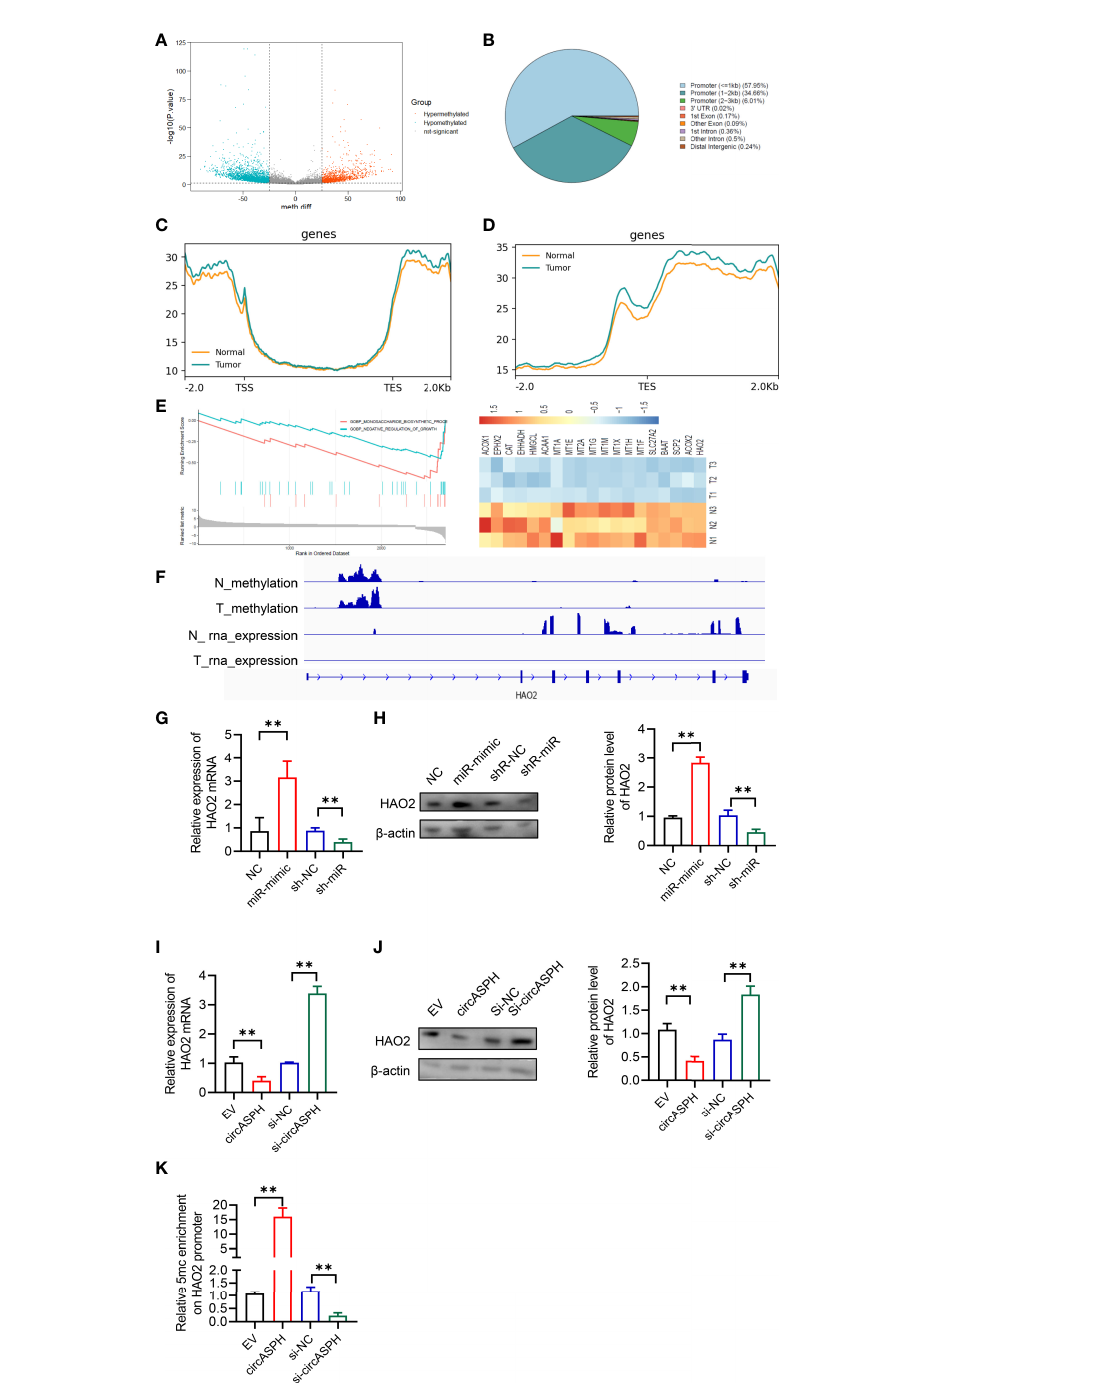
FIGURE 6 | CircASPH promoted HCC progression by regulating the DNA methylation and expression of HAO2. (A) Volcano plot of the methylation difference between HCC tumor tissues and normal tissues. (B) CpG island distribution of promoter differential methylated CpG sites. (C, D) Average pro fi les of 5mC and input DNA coverage across the binding-site motif identi fi ed on 5mCþ enhancers. (E) GSEA analysis of the gene enriched in the negative regulation of the growth pathway. (F) IGV pro fi le of 5mC-enriched regions and RNA-seq pro fi les in HCC tumor tissues. (G, H) The expression of the HAO2 level with miR-370-3p overexpression and knockdown was detected by RT-qPCR and Western blot. (I, J) The expression of the HAO2 level with circASPH overexpression and knockdown was detected by RT-qPCR and Western blot. (K) MeDIP-qPCR assays showed 5mC in HAO2 genes with different circASPH levels. **p <